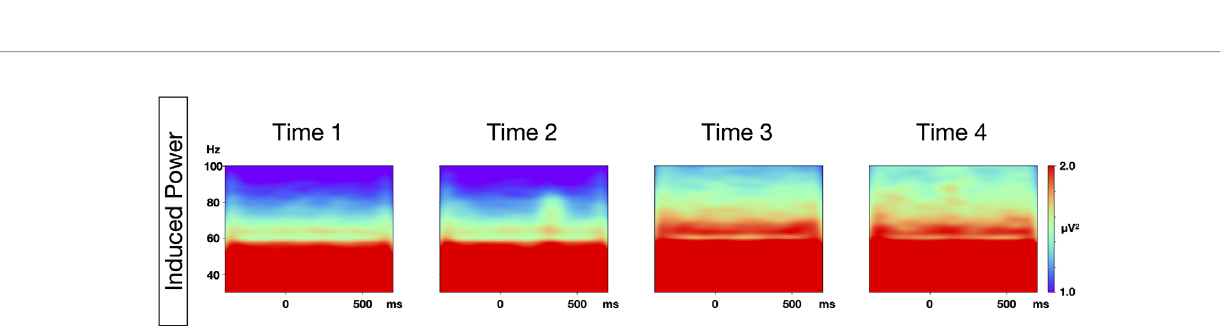
FIGURE 1 | Time-frequency maps of phase locking factor (PLF) and evoked power at each time points. Grand average time-frequency maps at Fz electrode, and topographies of PLF and evoked power within the range of 35 – 45 Hz, at each of the four time points.